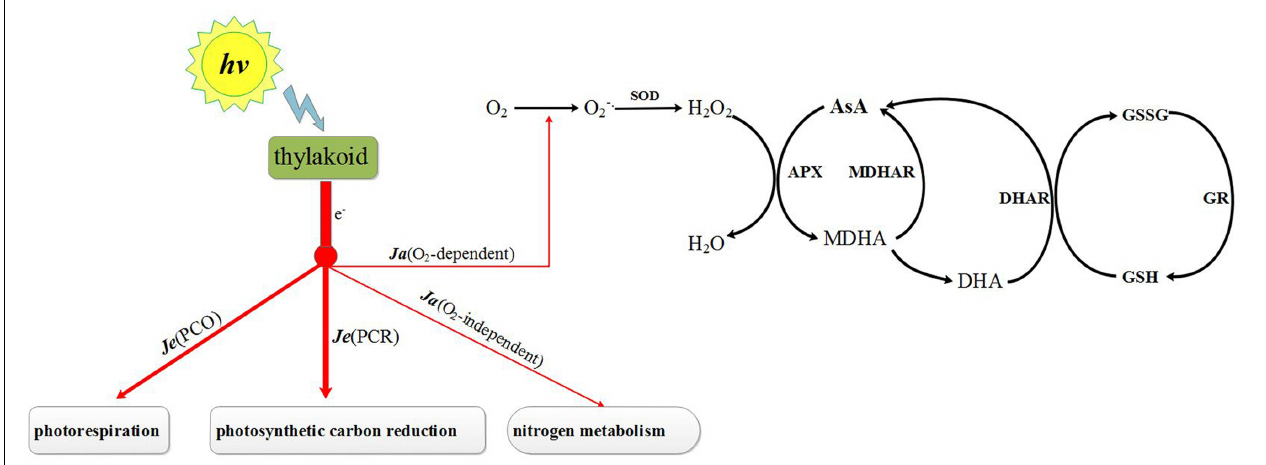
FIGURE 1 | Photosynthesis electron fluxes and AsA–GSH cycle in chloroplast. Je (PCR), electron fluxes associated with photosynthetic carbon reduction; Je (PCO), electron fluxes associated with photorespiration; Ja (O 2 -independent), O 2 -independent alternative electron fluxes; Ja (O 2 -dependent), O 2 -dependent alternative electron fluxes; SOD, superoxide dismutase; APX, ascorbate peroxidase; MDHAR, monodehydroascorbate reductase; DHAR, dehydroascorbate reductase; GR, glutathione reductase; AsA, ascorbate acid; MDHA, monodehydroascorbate; DHA, reduced ascorbate acid; GSH, glutathione; GSSG, oxidized